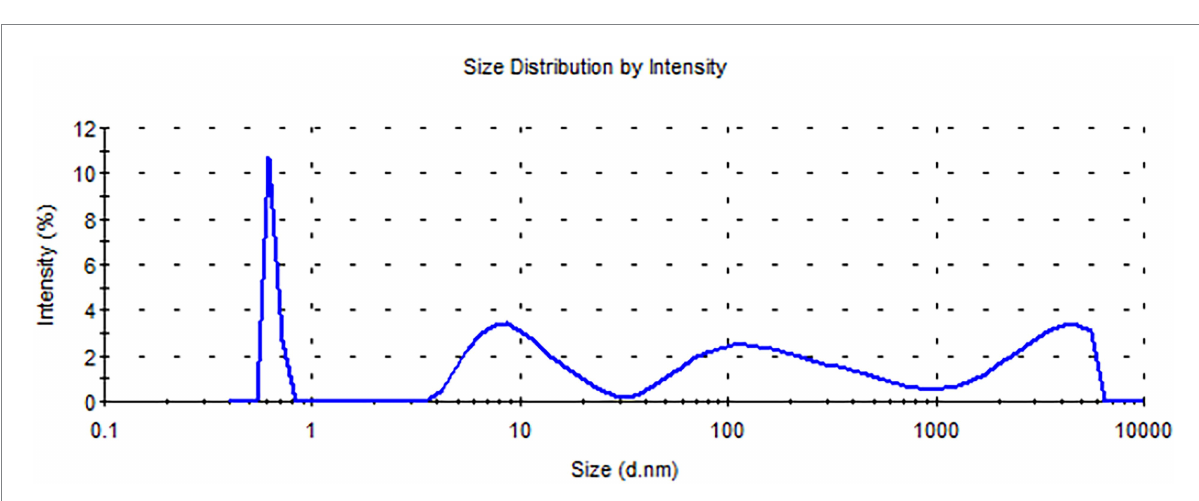
FIGURE 3 Droplet/particle distribution by intensity curve for the